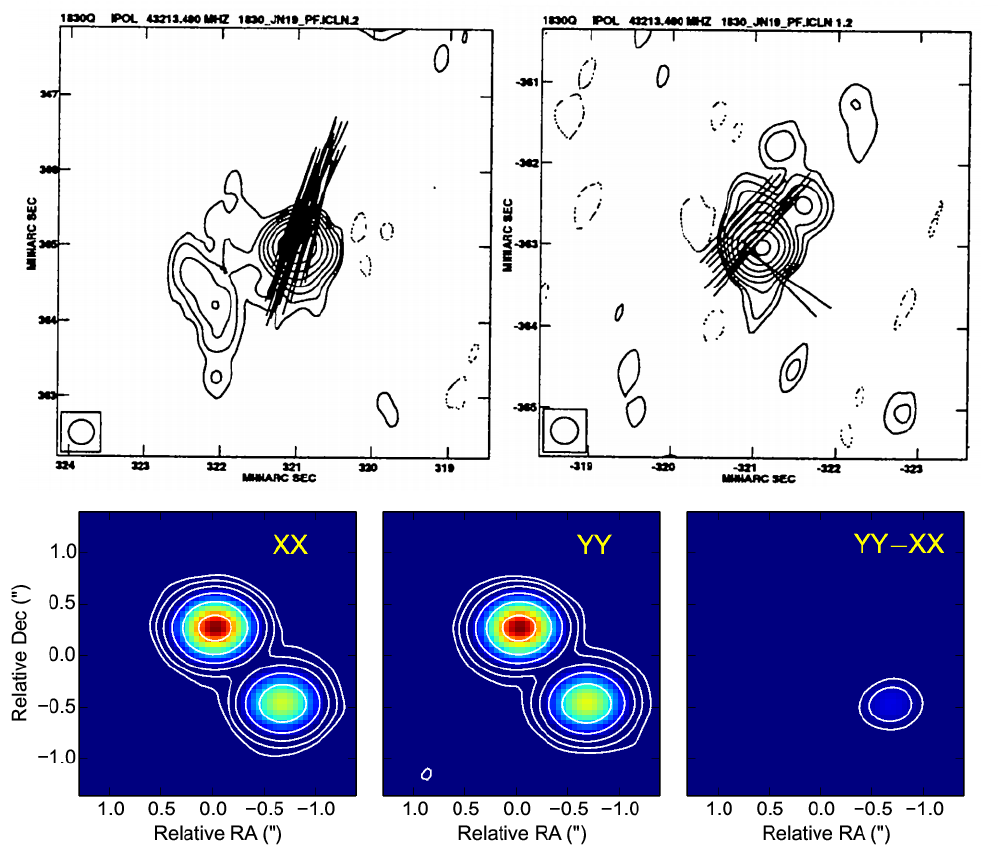
Figure 4. Top : VLBA images of the lensed images (labeled NE and SW) of PKS1830 − 211 at 7mm (taken from [24]; reproduced with the author’s permission). Notice the different polarization angle of the images, mainly due to the source variability, coupled to the time delay between images. Bottom : Two images of PKS1830 − 211 as seen by ALMA, at 1mm wavelength, in different polarization directions (similar to the results reported in [14]). Notice how the different polarizations produce a (time-varying) different contrast in the XX and YY images (image YY −